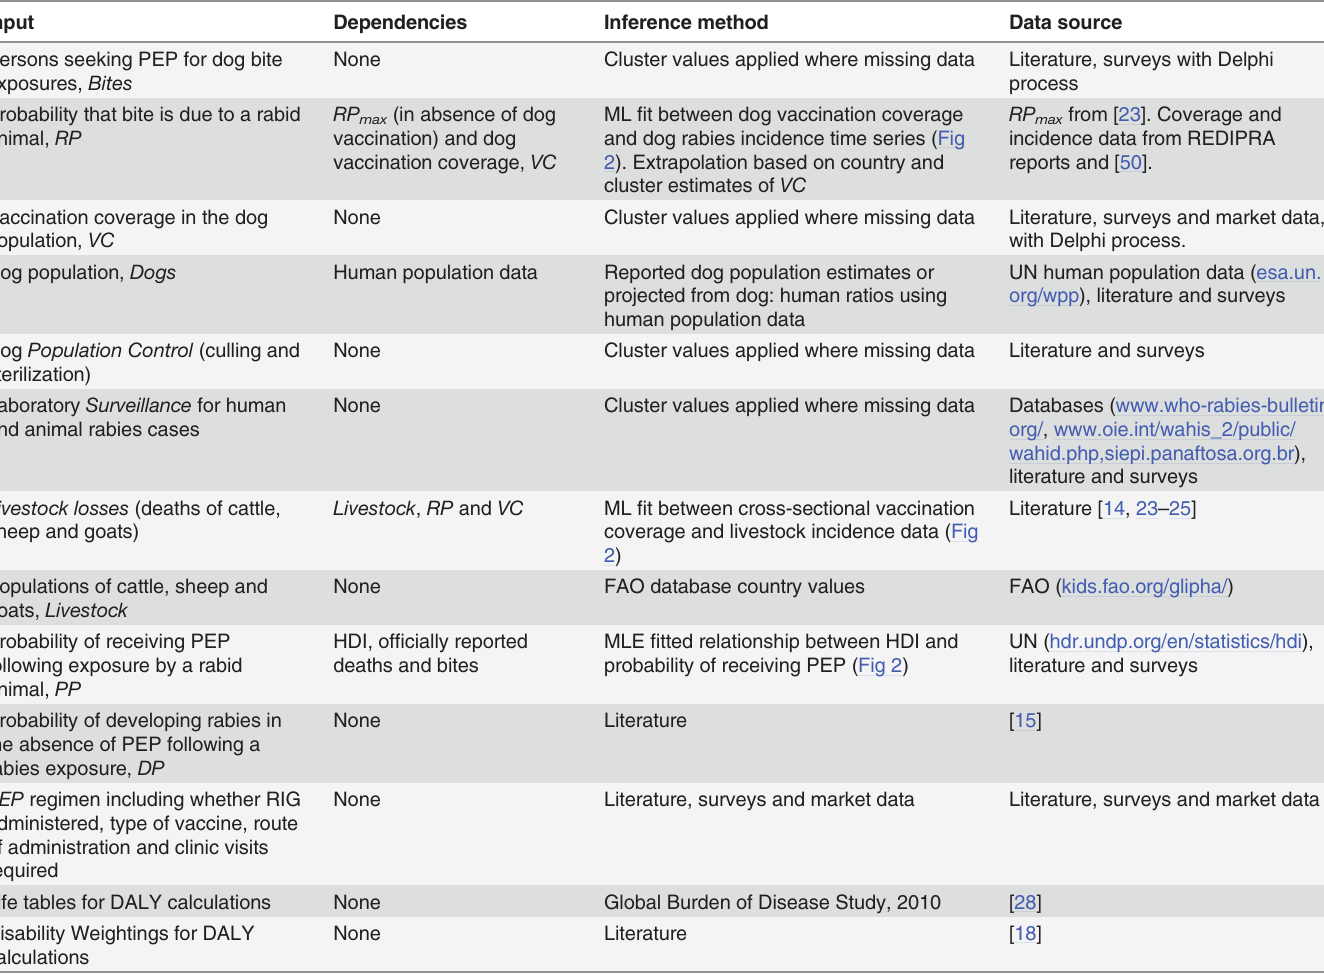
Table 1. Data sources and inference methods within framework used for estimating the burden of canine